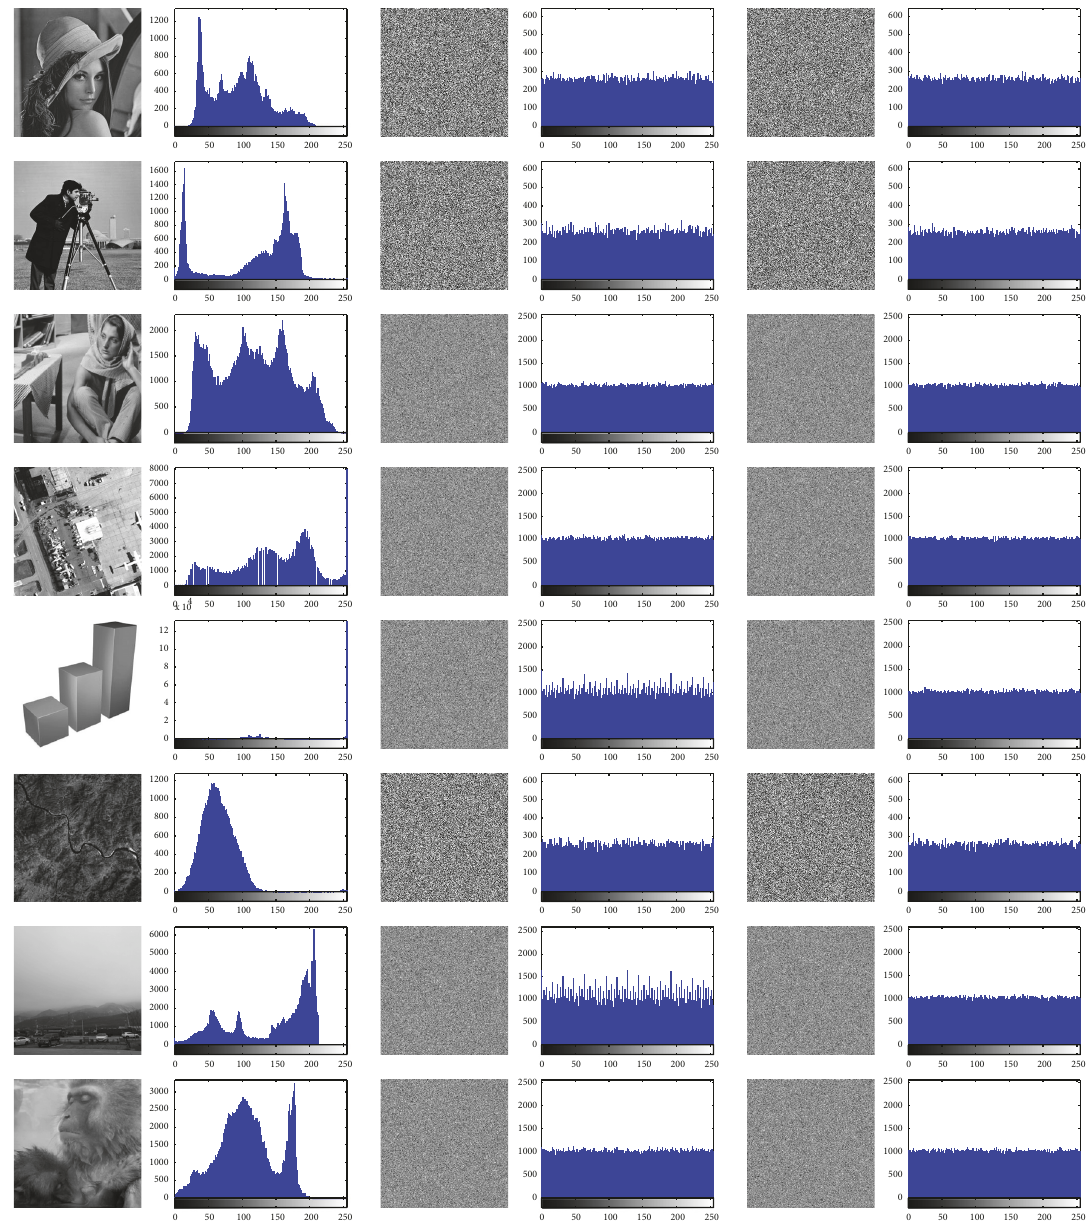
Figure 8: Histograms of the plain images and their corresponding encrypted images. The first column is plain images. The second column is the histograms of the plain images. The third column is diffusion result after 1D dynamic filtering. The fourth column is the histograms of the filtered image in the third column. The fifth column is encrypted images. And the sixth column is the histograms of the encrypted